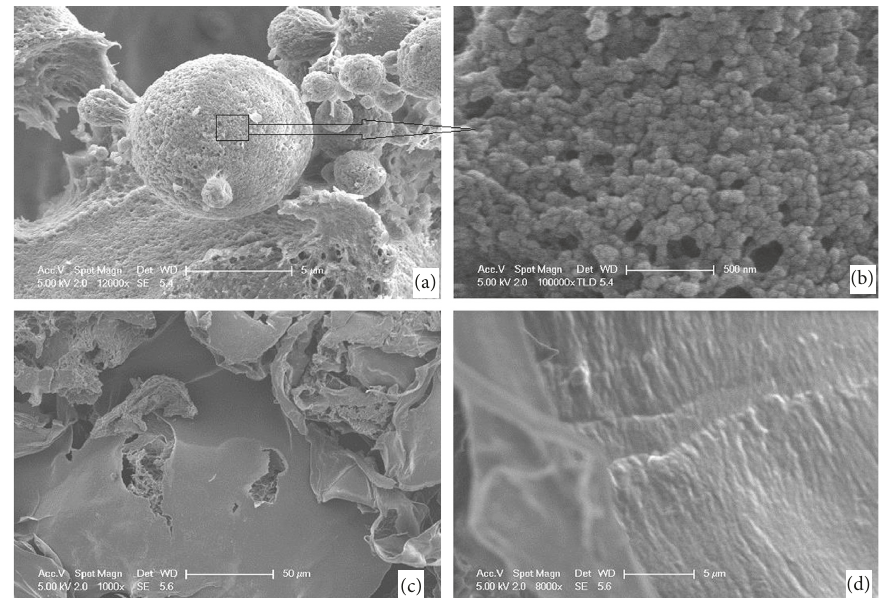
Figure 1: SEM images of fraction 1 regenerated with acetonitrile (a, b) and cellulose regenerated with water (c, d).